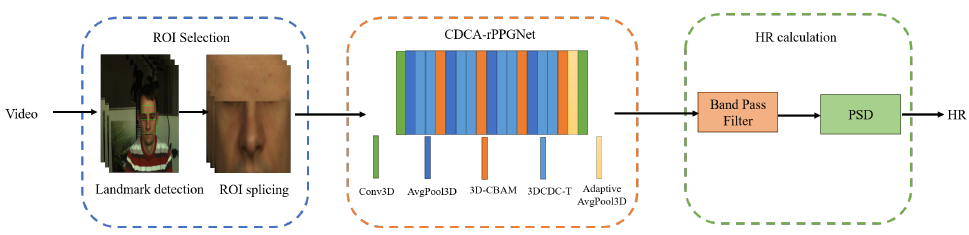
Figure 1. The overview of our